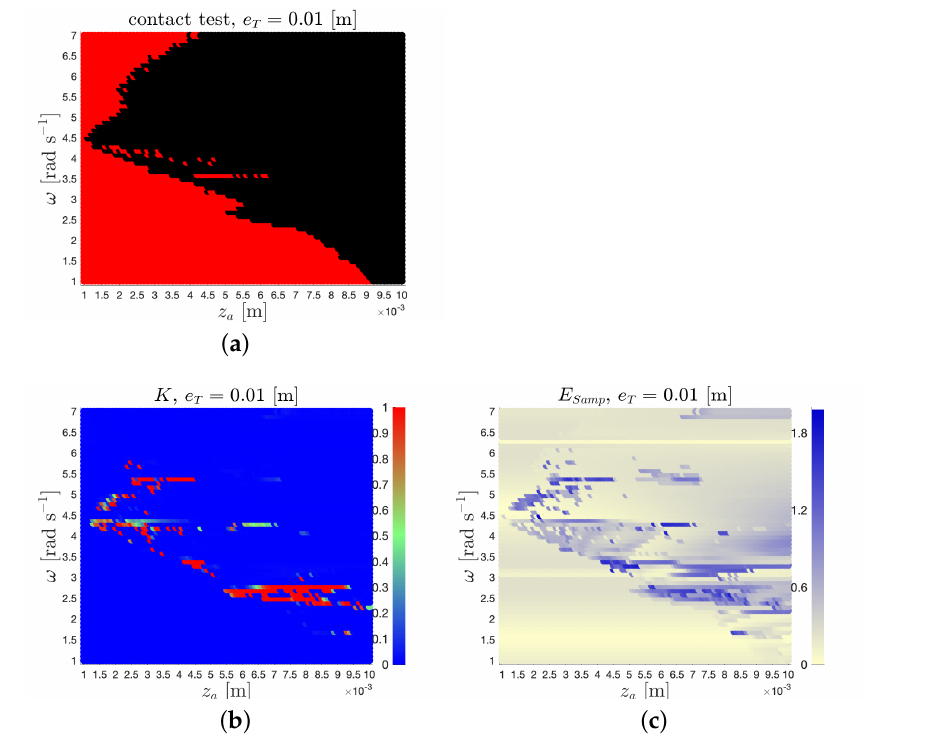
Figure 13. Outputs of the contact test ( a ), the 0–1 test for chaos K ( b ), and sample entropy E Samp ( c ) for eccentricity e T of 0.01 m with respect to the excitation frequency ω and amplitude z a .